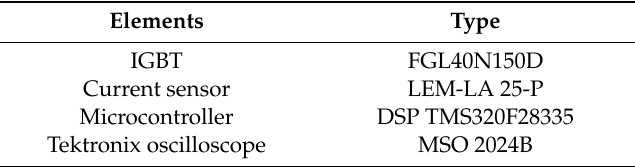
Table 5. Elements used in experiment.